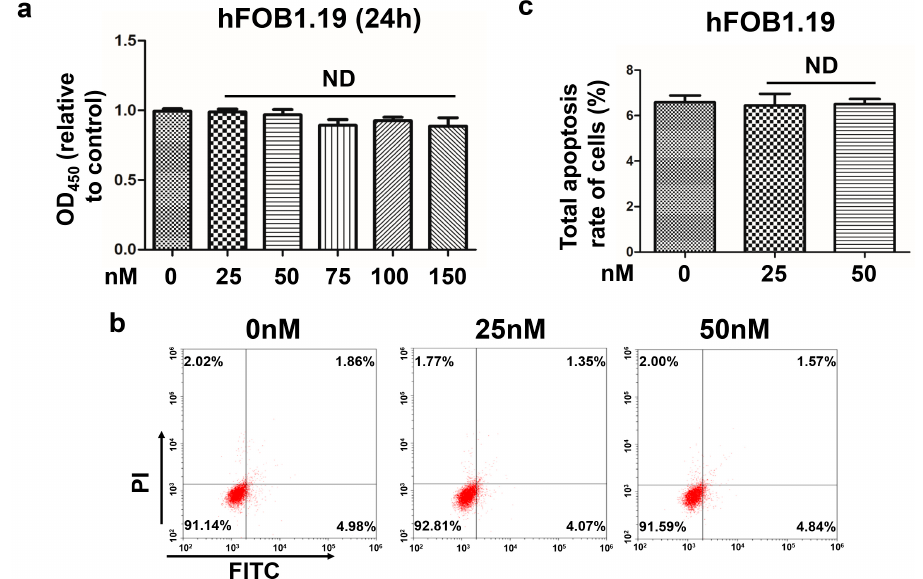
Figure 2. ( a ) The vitality of hFOB1.19 cell treated with different concentrations of oleandrin for 24 h that detected by CCK-8 assays; n = 5, Mean ± SEM; ND: no difference, vs. control (0 nM) group; ( b ) The apoptosis of hFOB1.19 cells treated with different concentrations of oleandrin that detected by FCM; and ( c ) Statistical analysis of the total apoptosis rate of hFOB1.19 cells followed by FCM detection; n = 3, Mean ± SEM; ND: no difference, vs. control (0 nM) group.